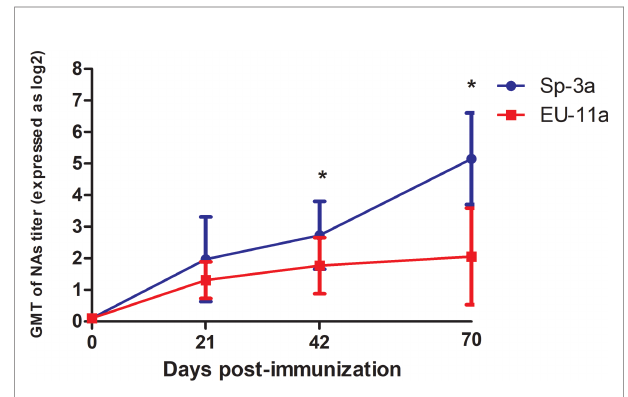
FIGURE 1 | Dynamics of development of NAs against the PRRSV isolate used for immunization in Experiment A and Experiment B. Statistically signi fi cant differences (p < 0.05) are marked with a *